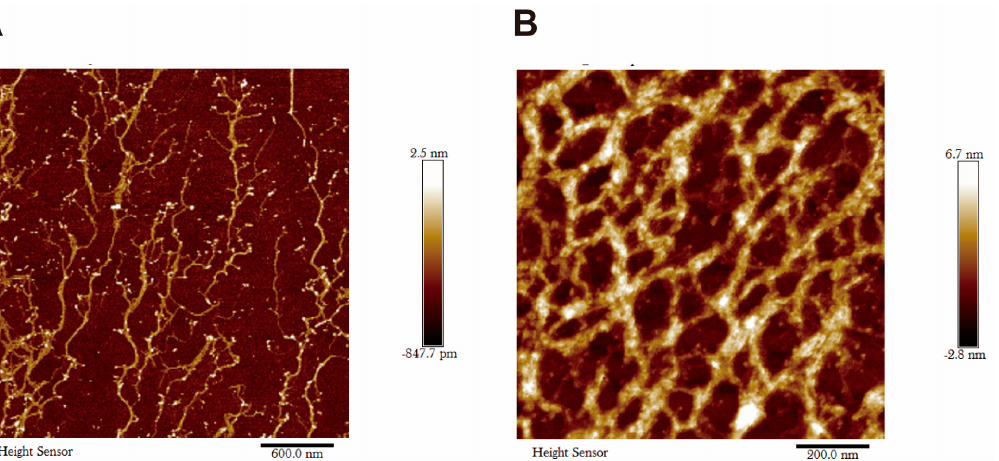
Figure 1. Microscopic morphology analysis of SCIBIOIII.AFM morphology of SCIBIOIII at 24 h. ( A ) AFM morphology of SCIBIOIII at 600 nm. ( B ) AFM morphology of SCIBIOIII at 200 nm. 2.1.2. SCIBIOIII Forms a Fibril-Like Membrane Sheet Structure upon the Addition of